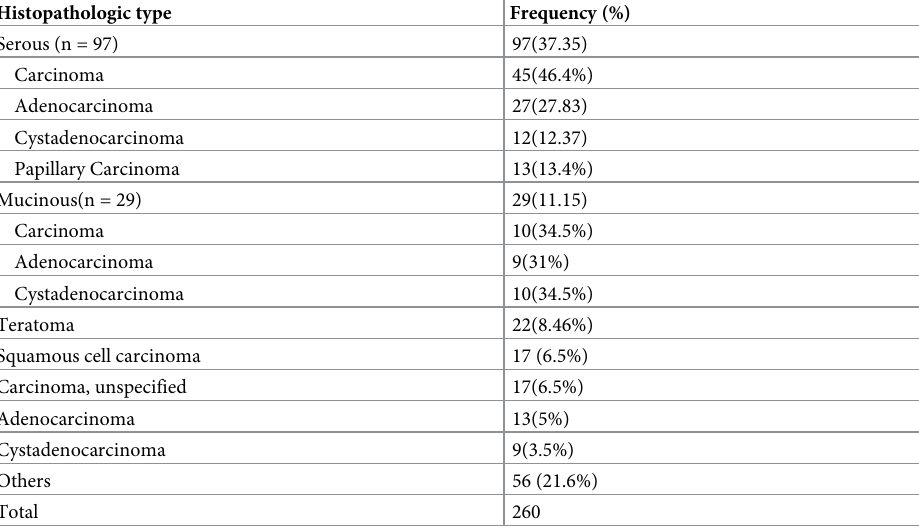
Table 4. Histopathological classification of ovarian cancer, 2014–18,